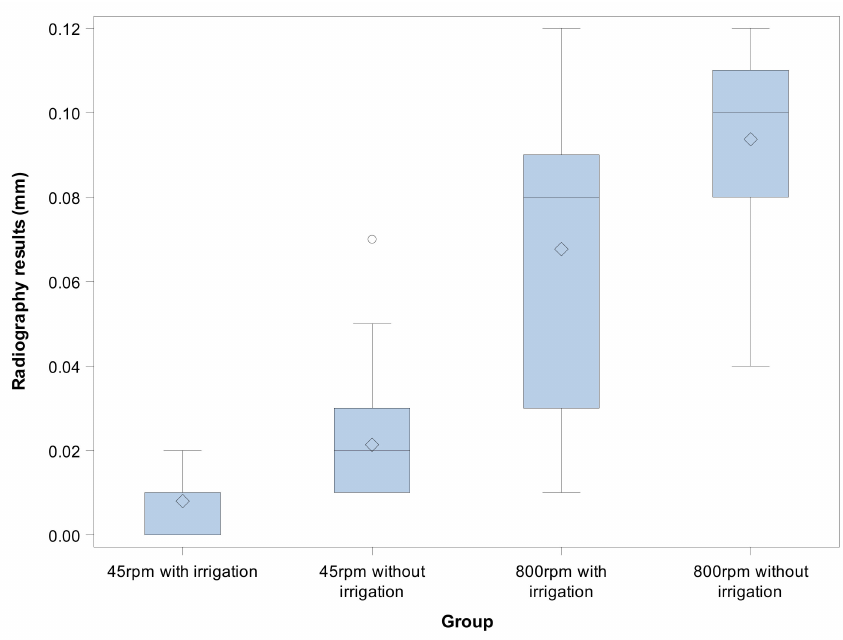
Figure 7. Box plots of the radiographic results of the experimental groups. The horizontal line in each box represents median